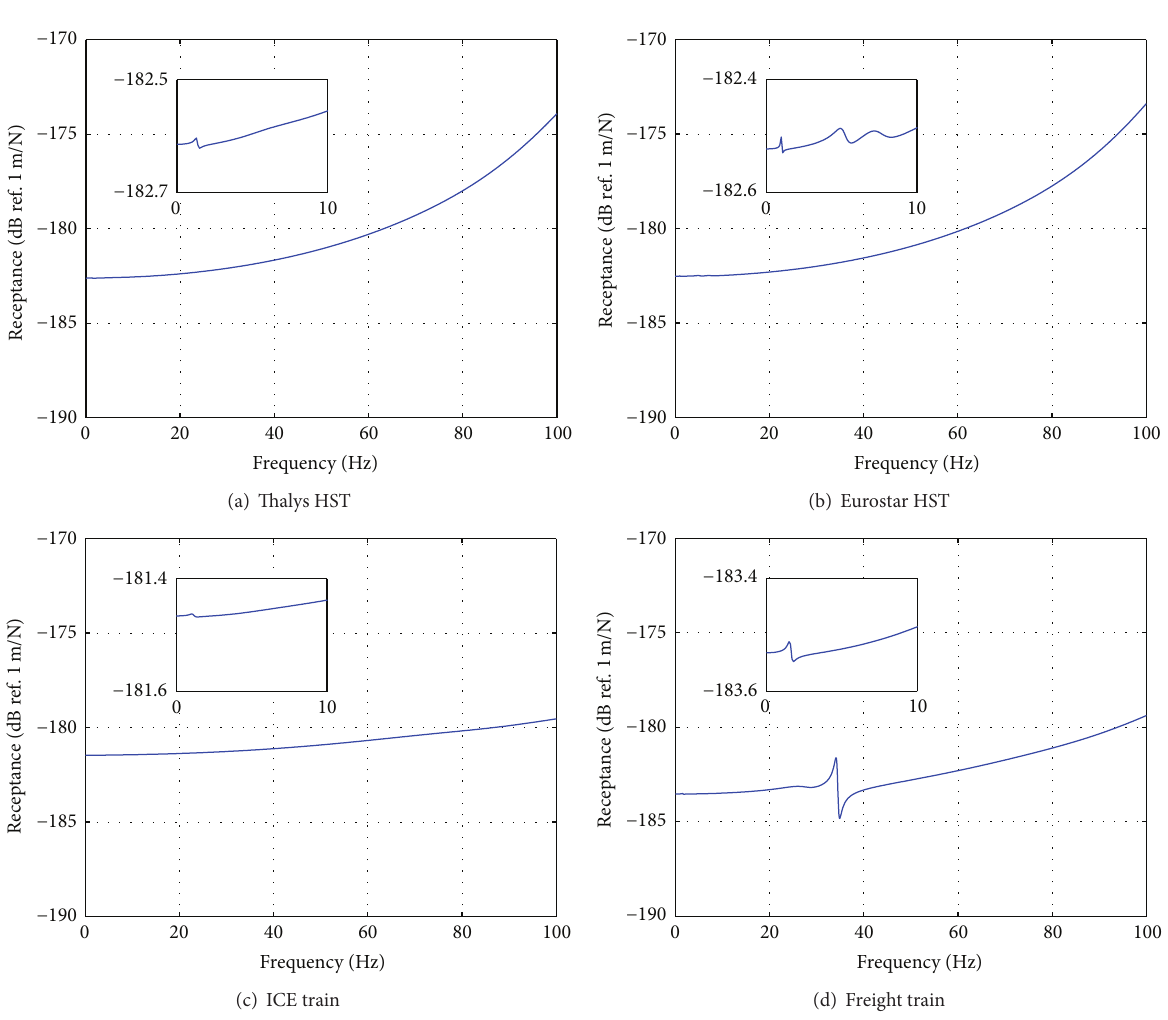
Figure 6: Spectral content of the first wheel receptances (calculated for a position of the wheel at midspan of sleepers).